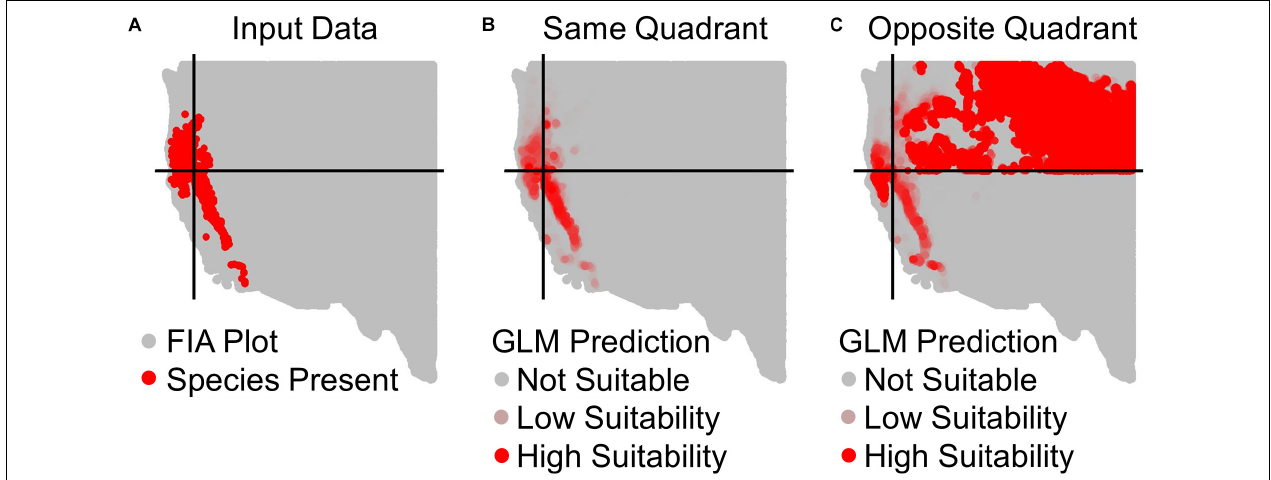
FIGURE 2 | Example prediction maps for Calocedrus decurrens using GLM. (A) The input FIA plots, where red are presences and gray are absences. Black lines designate the median latitude and longitude of presence plots, dividing the geographic space into our four quadrants specific to this species. (B) GLM predictions within the same quadrant as training data, where the intensity of red denotes the continuous output of habitat suitability. (C) GLM prediction to the opposite quadrant from the training data. The extreme over-prediction seen here in the northeast quadrant of the novel region predictions was a recurrent pattern typical across all quadrants and algorithms, except for